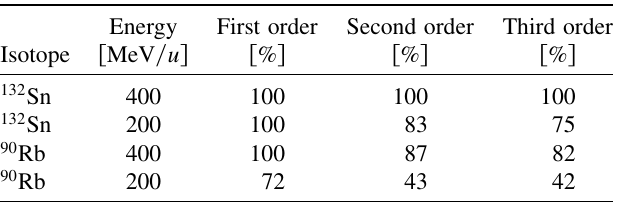
TABLE II. Transmission of 132 Sn and 90 Rb obtained from fission of 238 U . The acceptance of the system is large enough to fit in the kinematics of Sn at 400 MeV =u and it decreases with energy and mass.